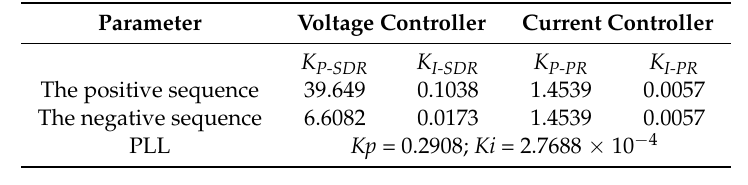
Table 1. Parameters of the controller.